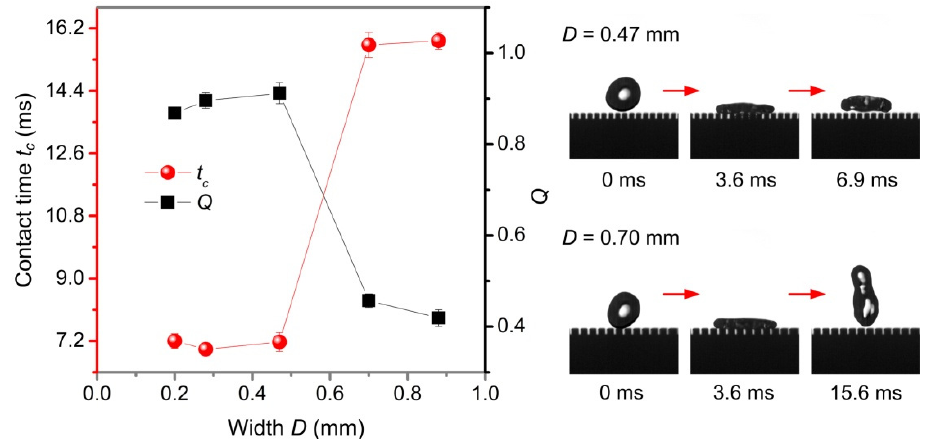
Figure 10. Contact time t c and Q of water droplets in a three-level structured plane surface as a function of width D .